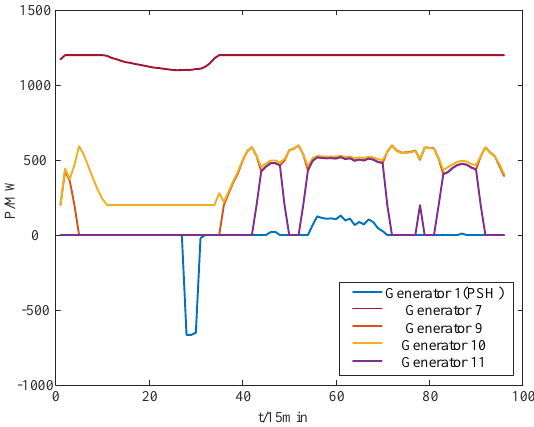
Figure 11. Active power output schedule of several gas-fired thermal units and PSH units.